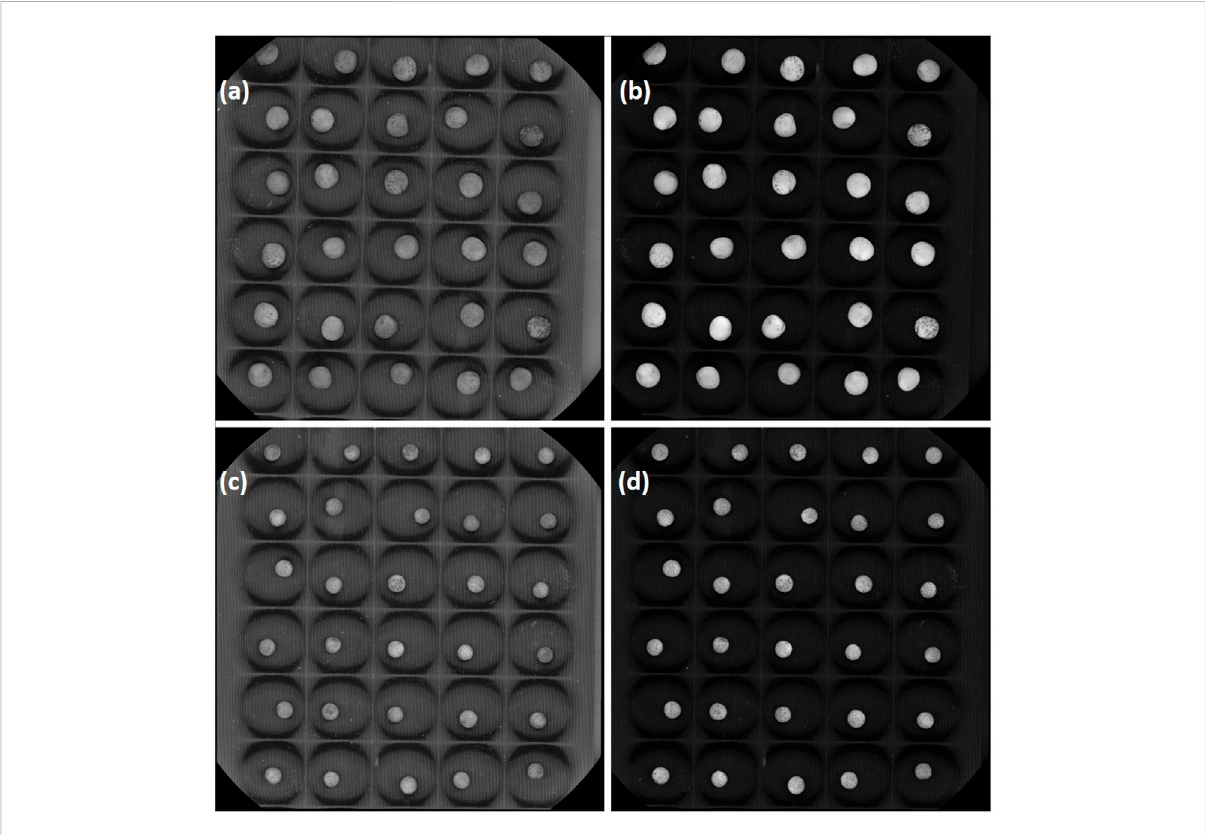
FIGURE 2 A representative mature seed photograph of lentil genotypes (A,B) L4602 and (C,D) L830 was taken at two different wavelengths [ (A,C) at 375 nm; (B,D) at 590 nm] using